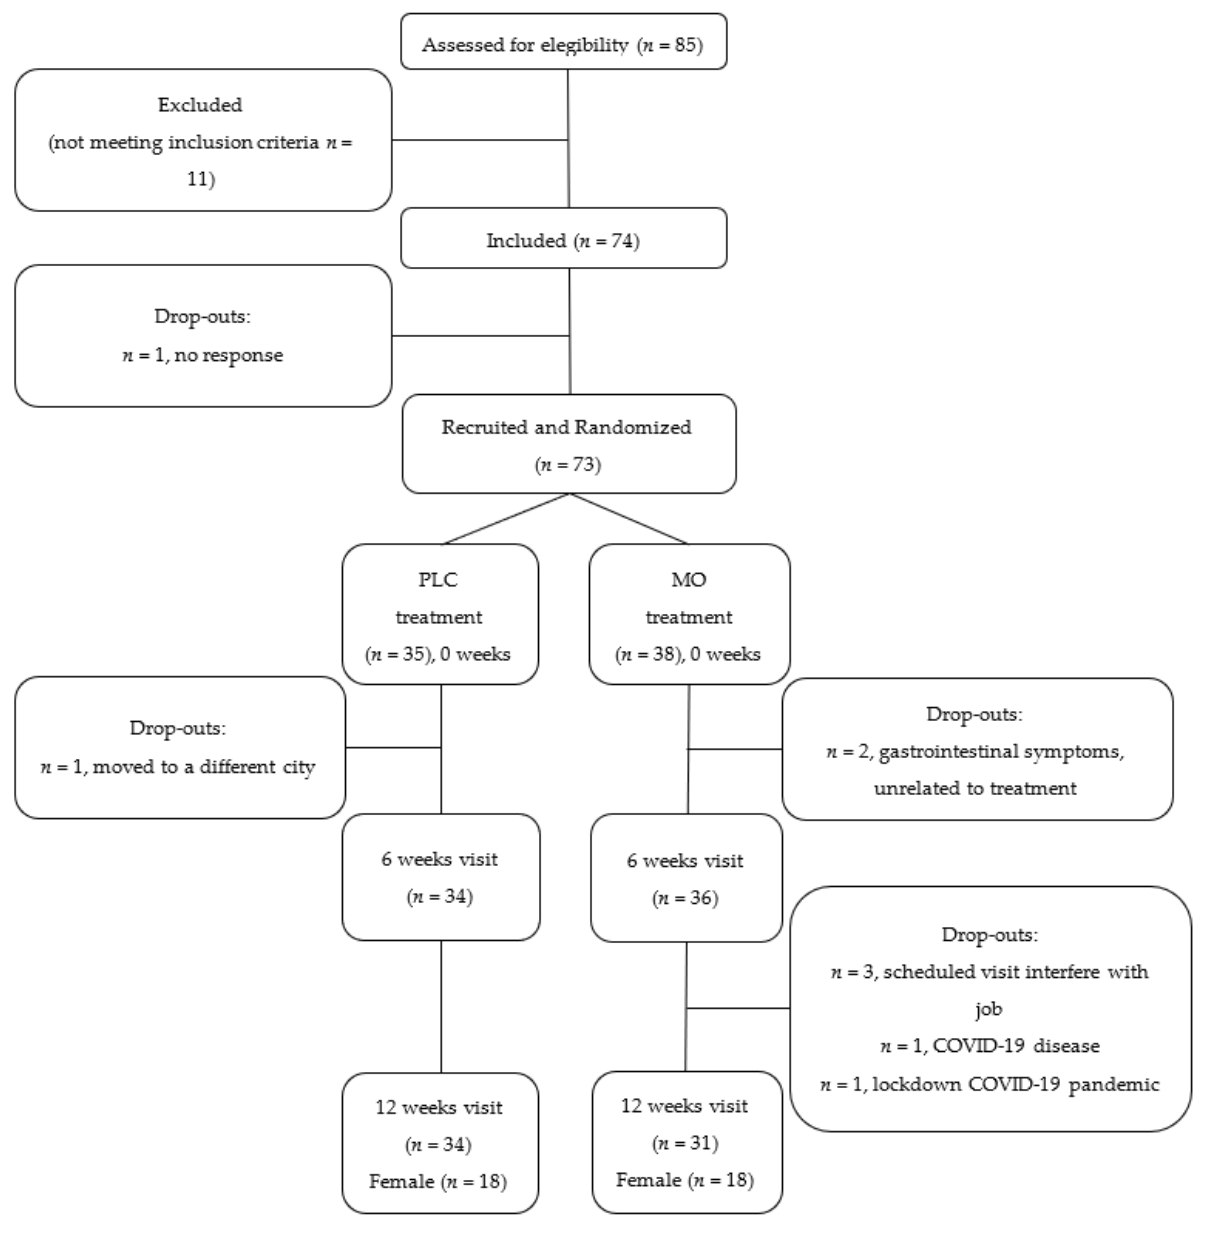
Figure 1. Flow chart of study participants.